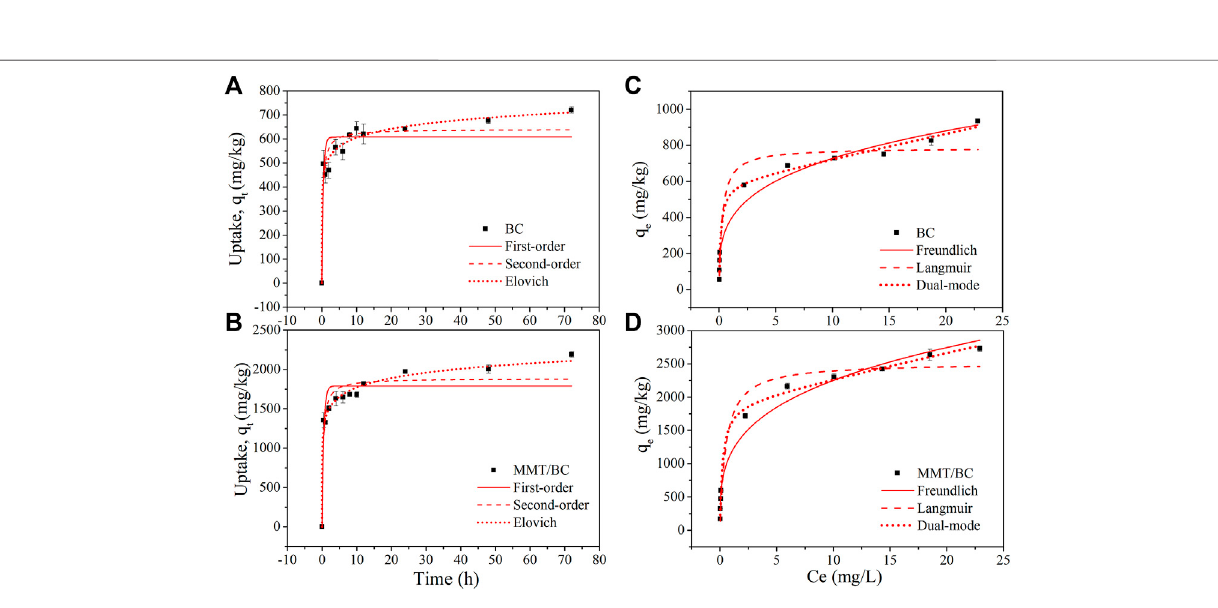
Frontiers in Environmental Science |